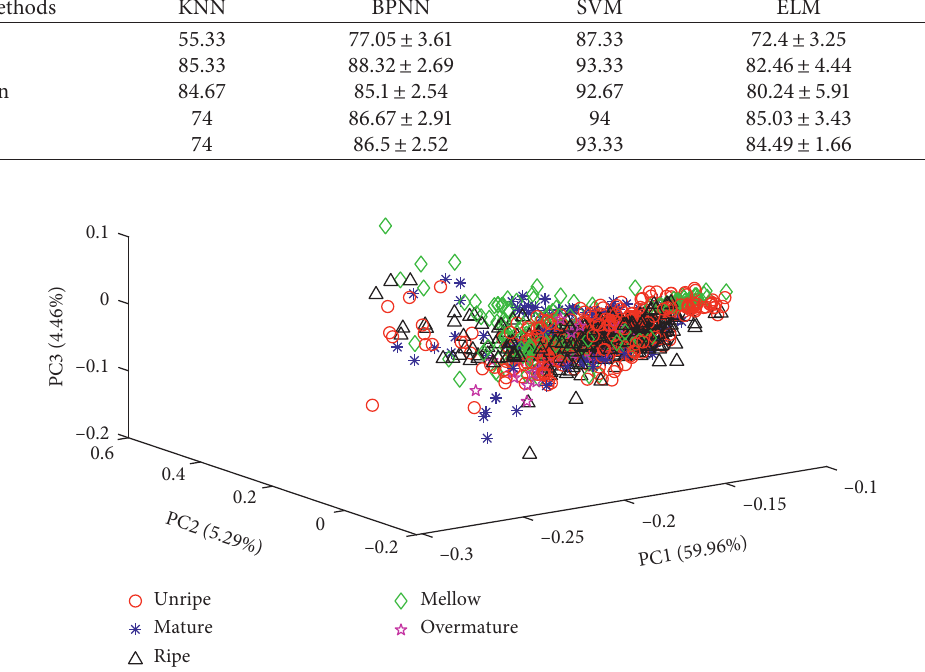
Figure 2: PCA score plot of the variance in NIR spectra of five maturity levels for upper tobacco leaves.